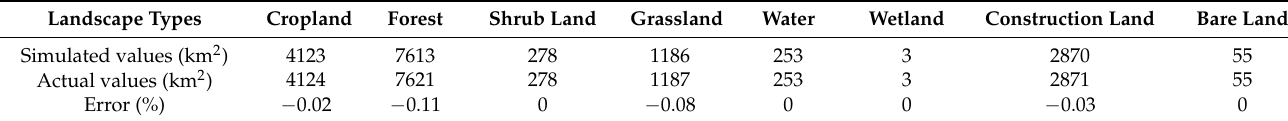
Table 3. Simulated and actual values of landscape types in